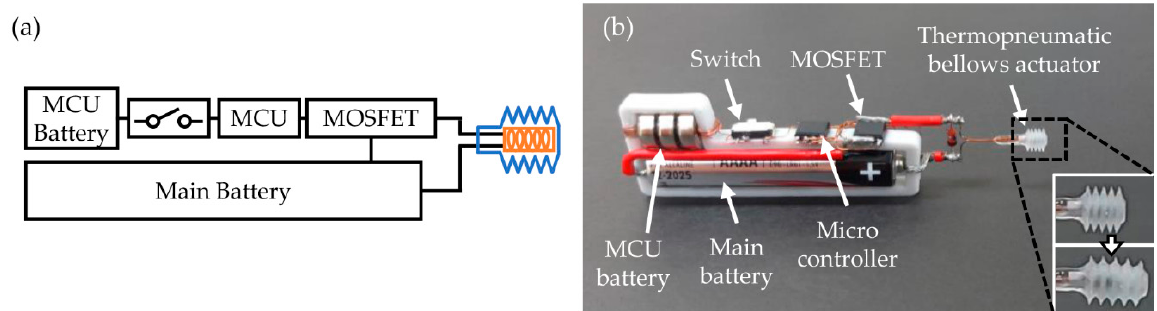
Figure 7. Independent drive system of thermopneumatic actuator. ( a ) Schematic diagram of the autonomous system for standalone operation of the thermopneumatic bellows actuator. ( b ) Photograph of an independent circuit (bird’s eye view): button cell battery for MCU, MOSFET for switching, MCU for controlling the signal, a 1.5 V alkaline battery for supplying power to the heater.